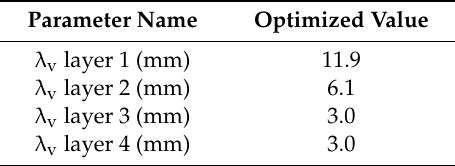
Table 4. Vertical dispersivity values obtained by inverse modeling in the STD and No-till+CMP experimental plots.